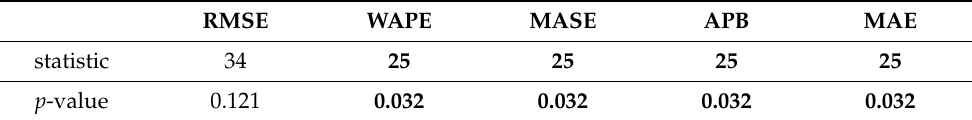
Table 4. U-Mann Whitney